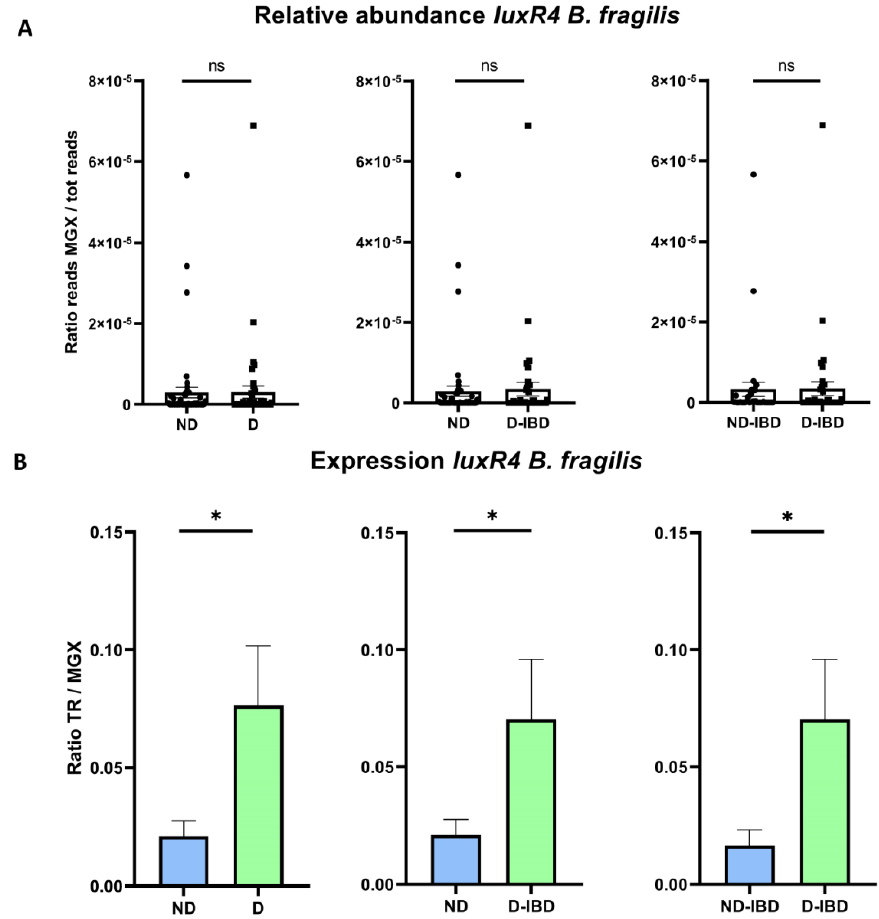
Figure 5. Relative abundance and expression of luxR4 Bacteroides fragilis (B. fragilis) according to dysbiosis status. ( A ) Relative abundance of luxR4 B. fragilis expressed as the ratio of gene reads over the total number of reads in the sample (Mann–Whitney U test). ( B ) Expression of luxR4 B. fragilis expressed as a ratio of gene reads in the transcriptome over the gene reads in the metagenome (Mann – Whitney U test). In all panels, ns: non-significant; * p < 0.05, ND: non-dysbiotic, D: dysbiotic, D-IBD: dysbiotic IBD, ND-IBD: non-dysbiotic IBD, MGX: metagenome, TR: